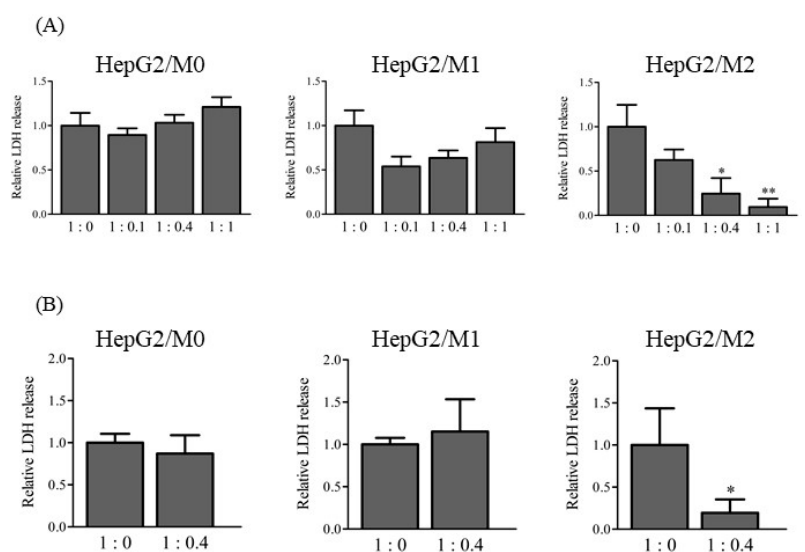
Figure 2. Relative LDH release to 1:0 in direct co-culture HepG2/M0, M1, and M2 (1:0, 1:0.1, 1:0.4, and 1:1) ( A ), and in indirect co-culture HepG2/M0, M1, and M2 (1:0.4) ( B ) 24 h after DIC treatment